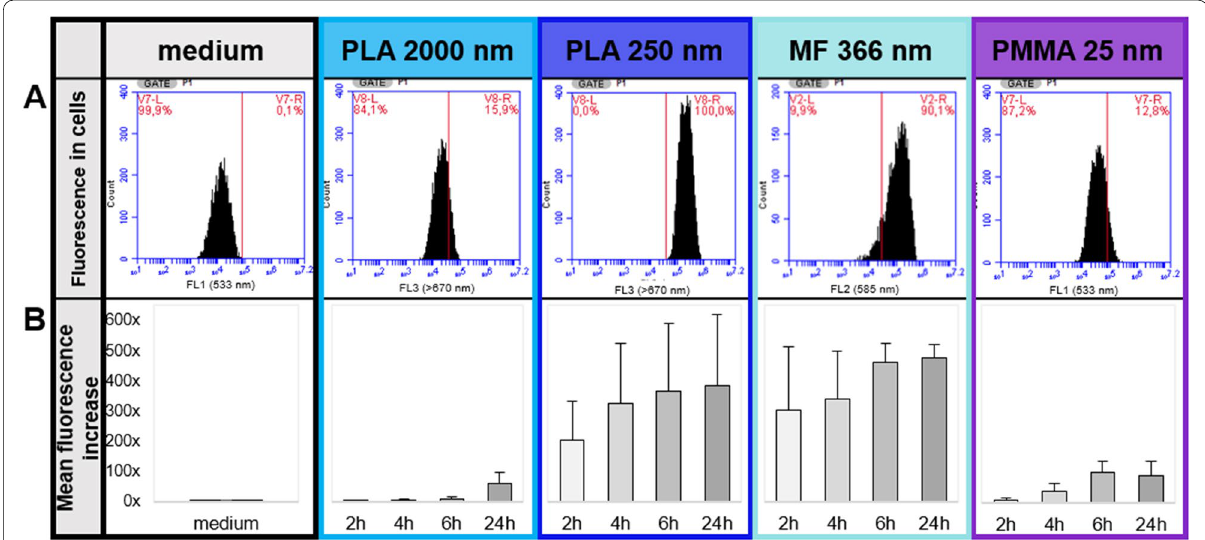
Fig. 5 Quantification of uptake of particles in HepG2 cells after 24 h ( A ) and 2, 4, 6, 24 h ( B ) incubation. A Representative Histograms depicting the count of fluorescence signals dependent on the fluorescence intensity. The vertical red line shows the division between intrinsic fluorescence of the cells (see medium) and increasing fluorescence signals after particle uptake. The percentage of the uptake is depicted in the upper right corner. B Mean fluorescence increase after incubation of HepG2 with particles after 2, 4, 6, and 24 h incubation, respectively. Quantification was determined related to medium. Data are shown as means SD, n ± =